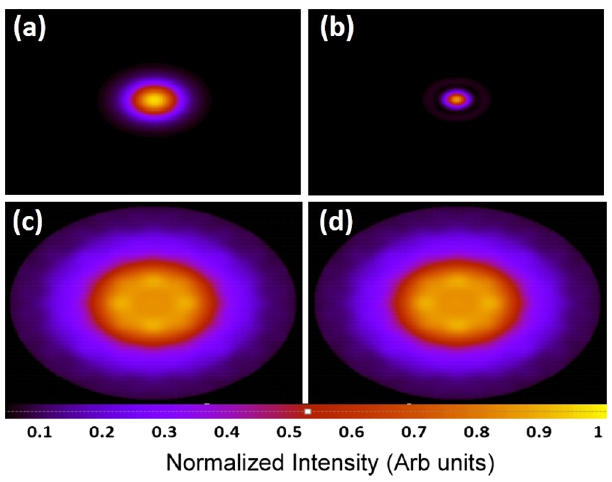
FIG. 4. Mode profiles obtained from our analytic model, at a wavelength of 10 μ m, in the confocal configuration with an electron beam current of (a) I ¼ 5 A and (b) I ¼ 55 A, and in the concentric configuration with (c) I ¼ 5 A and (d) I ¼ 55 A. For each plot the window size is 50 mm by 50 mm.